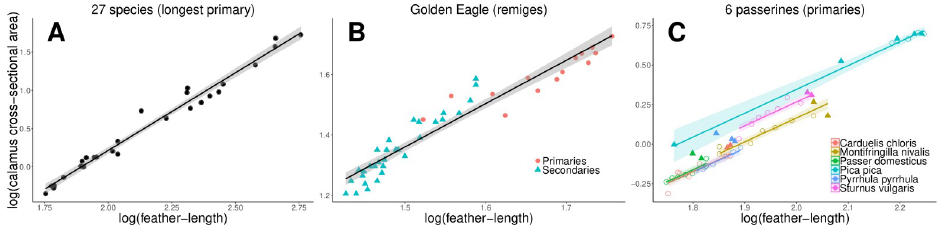
Fig 3. Cross-sectional area of the calamus and feather-length. Relationships between the cross-sectional area of the calamus and feather-length for three datasets: A: longest primary of 27 species, B: remiges of Golden Eagle (dots = primaries, triangles = secondaries), C: primaries of 6 passerine species (colours; filled triangles = ‘wing-tip primaries’, = open circles ‘proximal primaries‘). The cross-sectional area of the calamus in addition depends on the mass of feather material per mm feather-length which is not depicted (see text and Table 2). The lines indicate the regressions according to the analyses (see Table 2 and S2 Table, S4 Table and S6 Table): A and B: for the entire dataset; C: for the ‘proximal primaries’ only with a different intercept according to